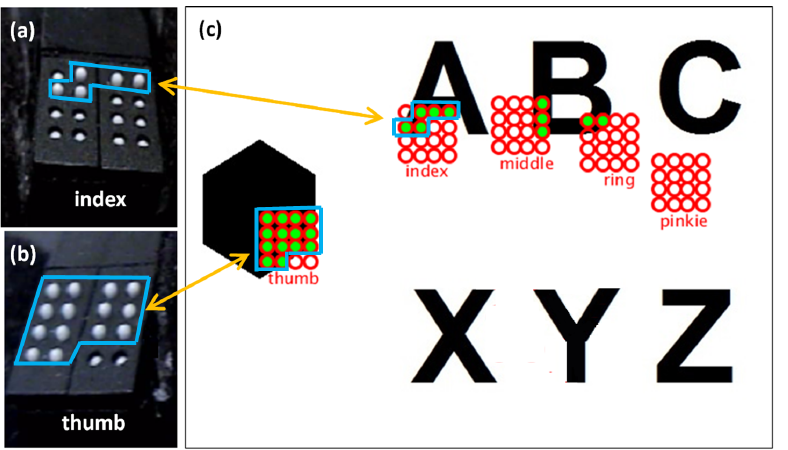
Figure 7. Fingertip tactile matrices, and graphical user interface (GUI) developed using Processing. The activated pins of ( a ) index fingertip and ( b ) thumb tactile matrices correspond to each small section, and ( c ) corresponding activation of index shown in Figure 7a and thumb in Figure 7b are shown in shaded green in simulator matrices in the